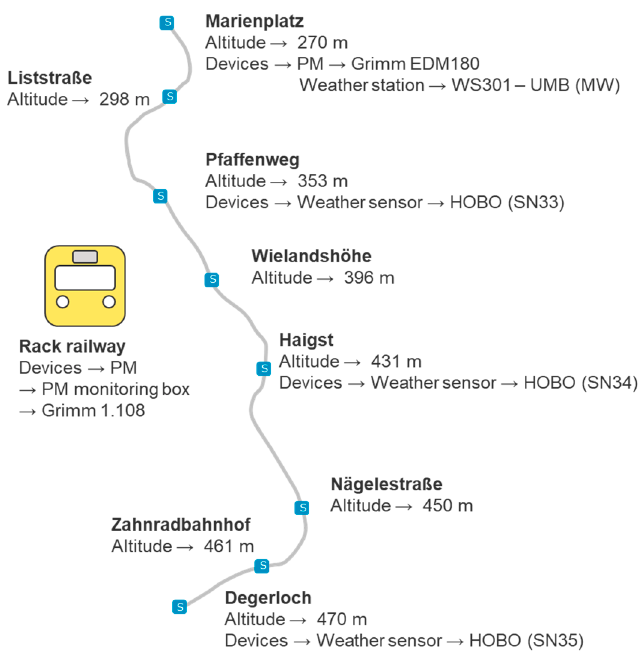
Figure 5. The distribution of the used devices along the route of the rack railway.